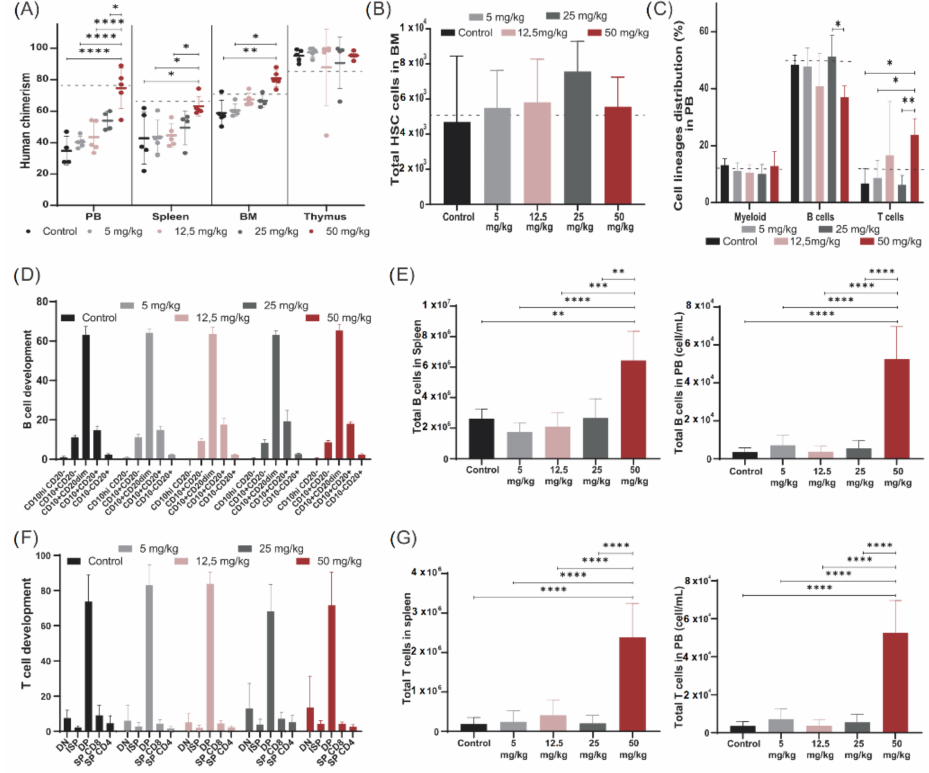
Figure 2. Modeling busulfan conditioning in NSG mice, determining a suitable dose. NSG mice were preconditioned with increasing doses of busulfan (control, 5 mg/kg, 12.5 mg/kg, 25 mg/kg and 50 mg/kg) and transplanted with 100,000 human CD34 cells (5 mice/group). ( A ) Human chimerism (% hCD45 cells) achieved in PB, spleen, bone marrow (BM) and thymus 20 weeks after transplantation. Human chimerism achieved by TBI represented by dashed line. (Two-way ANOVA; * p < 0.05, ** p < 0.01, *** p < 0.001, **** p < 0.0001). ( B ) Total number of human hematopoietic stem cells (HCS) in NSG BM 20 weeks after transplantation. ( C ) Cell lineage distribution (myeloid, B and T cells) in PB 20 weeks after transplantation of the different conditioned groups. (Two-way ANOVA; * p < 0.05, ** p < 0.01). ( D ) Proportion of B cell developmental stages in BM in the different busulfan-treated mice. ( E ) Total B cell counts in spleen and in PB 20 weeks after transplantation. (One-way ANOVA; ** p < 0.01, *** p < 0.001, **** p < 0.0001). ( F ) Proportional T-cell developmental stages in the thymus in the different busulfan-treated mice. ( G ) Total T cell counts in spleen and in PB 20 weeks after transplantation. (One-way ANOVA; **** p <